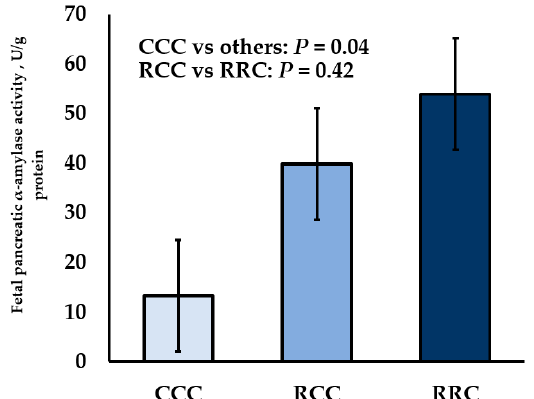
Figure 1. Influence of maternal dietary intake restriction (60% of NRC [39] recommendations) of cows during early-gestation (RCC; day 30 to day 85) or early- to mid-gestation (RRC; day 30 to day 140) on fetal pancreatic α -amylase activity per gram of protein (U/g protein) from